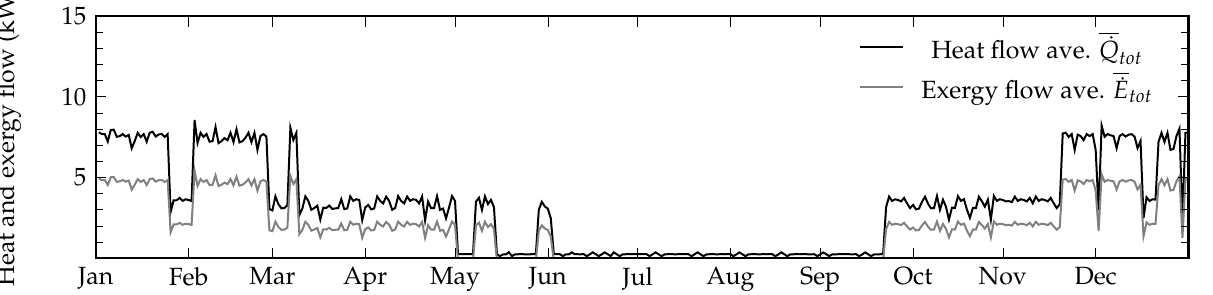
Figure 10. Daily averaged values of the heat flow and the exergy flow of the system in a residential building in the course of a